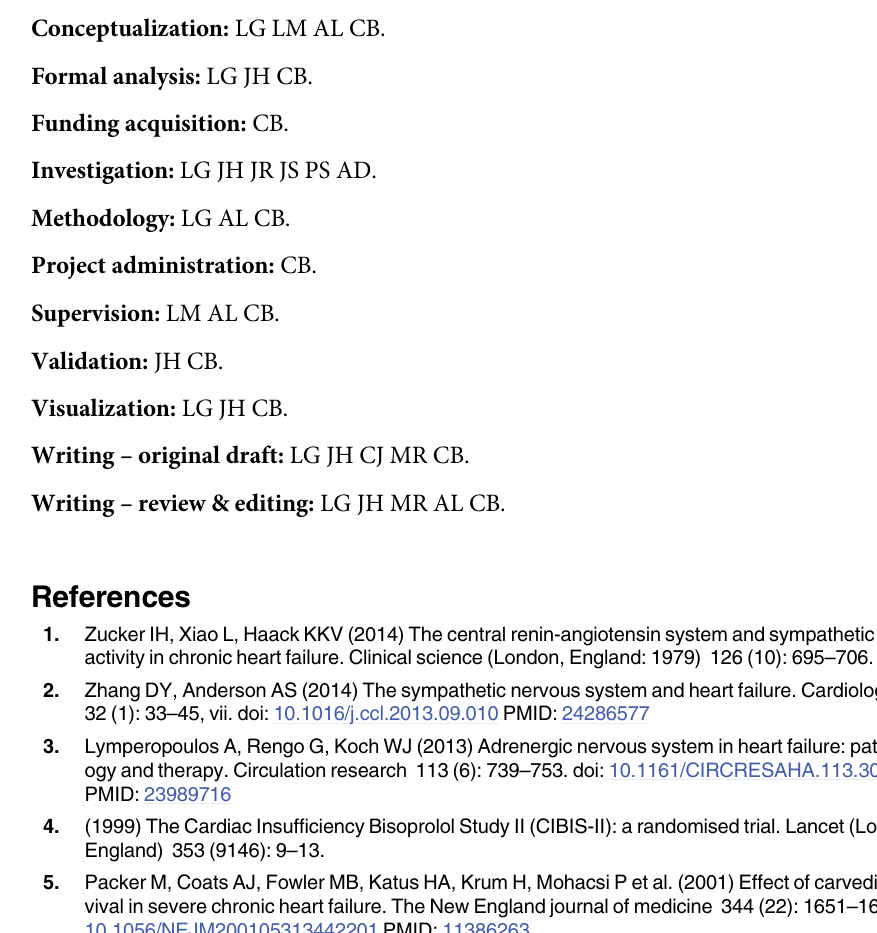
S20 Fig. Intermediate filaments in ELVD vs. CHF. S21 Fig. Fat metabolism in ELVD vs. CHF. S22 Fig. Ribosomal proteins in ELVD vs. CHF. S23 Fig. Transport proteins in ELVD vs.